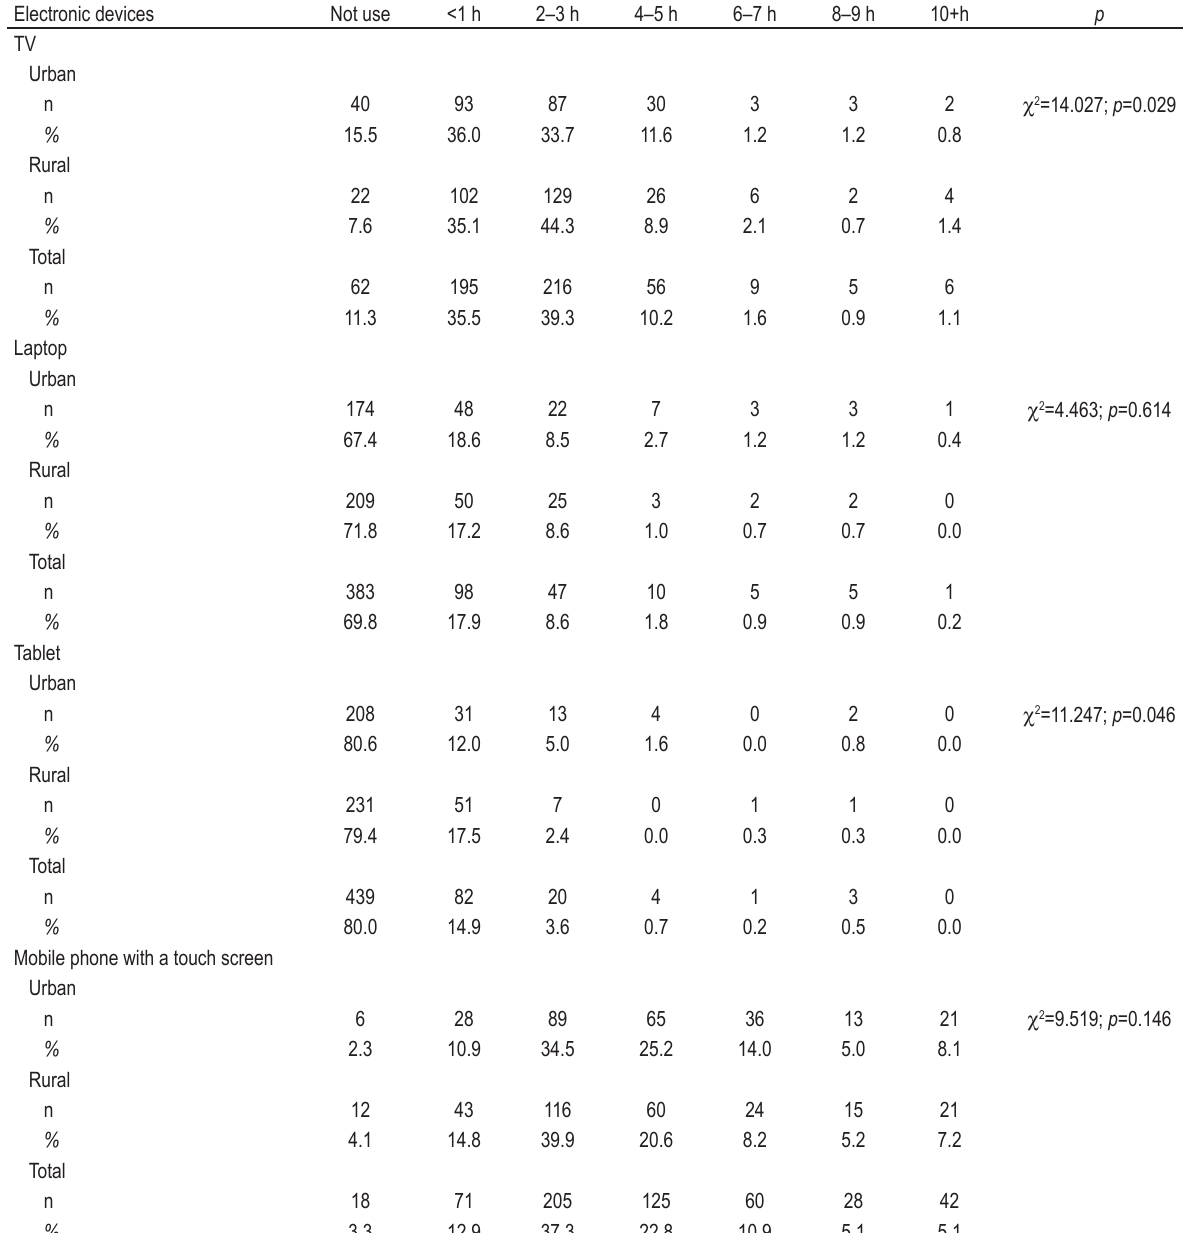
TABLE 2. The review of using electronic devices at the weekend (Saturday–Sunday) according to areas Electronic devices